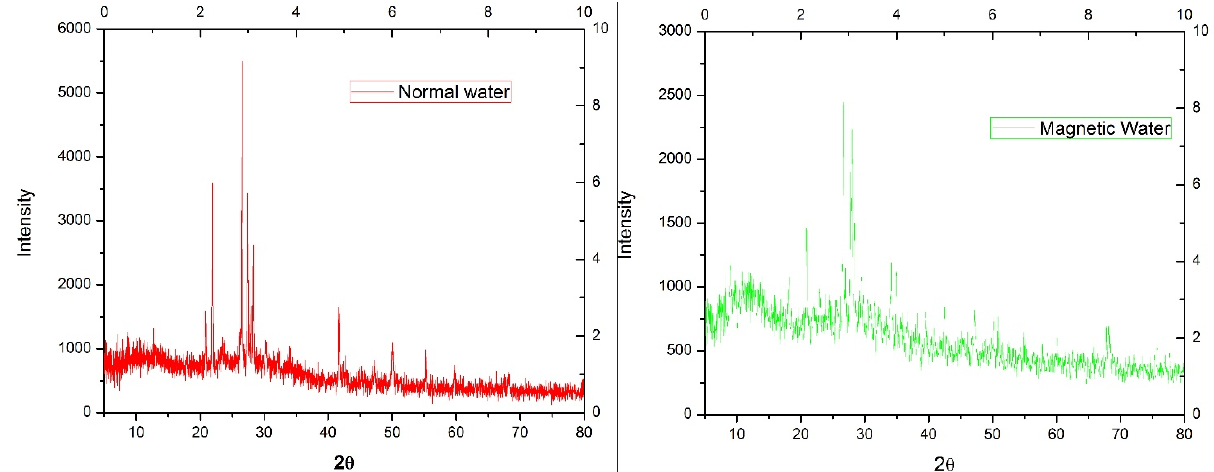
Figure 6. X ‐ ray diffraction spectrum of normal water and magnetic water. Figure 6. X-ray diffraction spectrum of normal water and magnetic